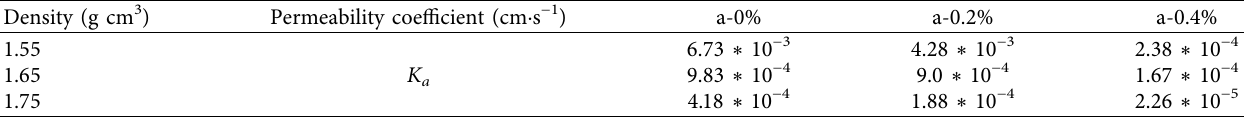
Table 3: Permeability coefficient of